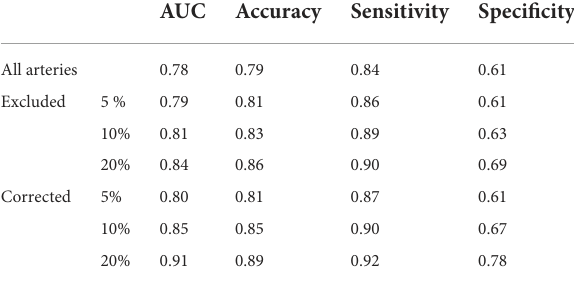
TABLE 5 Performance of our method on Test Cath when a percentage of cases with the highest uncertainty is excluded or corrected to the reference FFR.